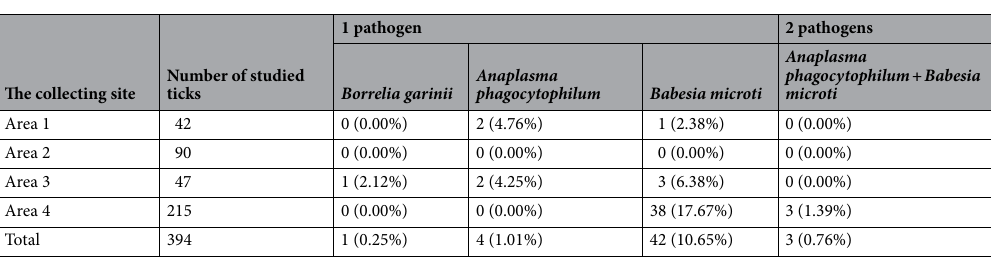
Table 1. Number and percentage of Ixodes ricinus infected with Borrelia garinii , Anaplasma phagocytophilum and Babesia microti in the studied areas of the Wolinski National